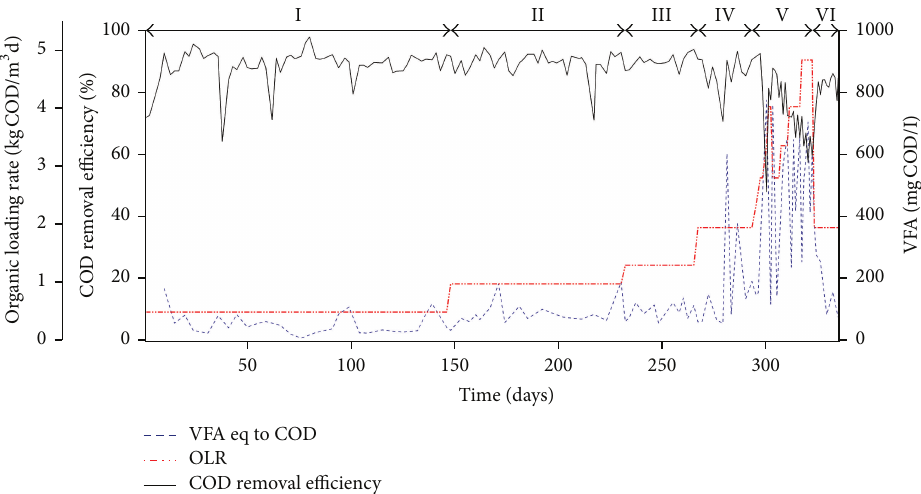
Figure 1: Chemical Oxygen Demand (COD) removal efficiency (RE), Volatile Fatty Acids (VFA concentrations; presented as sum of acetic-, butyric-, iso-butyric-, propionic-, valeric-, and iso-valeric), and organic loading rate (OLR) applied to the expanded granular sludge bed